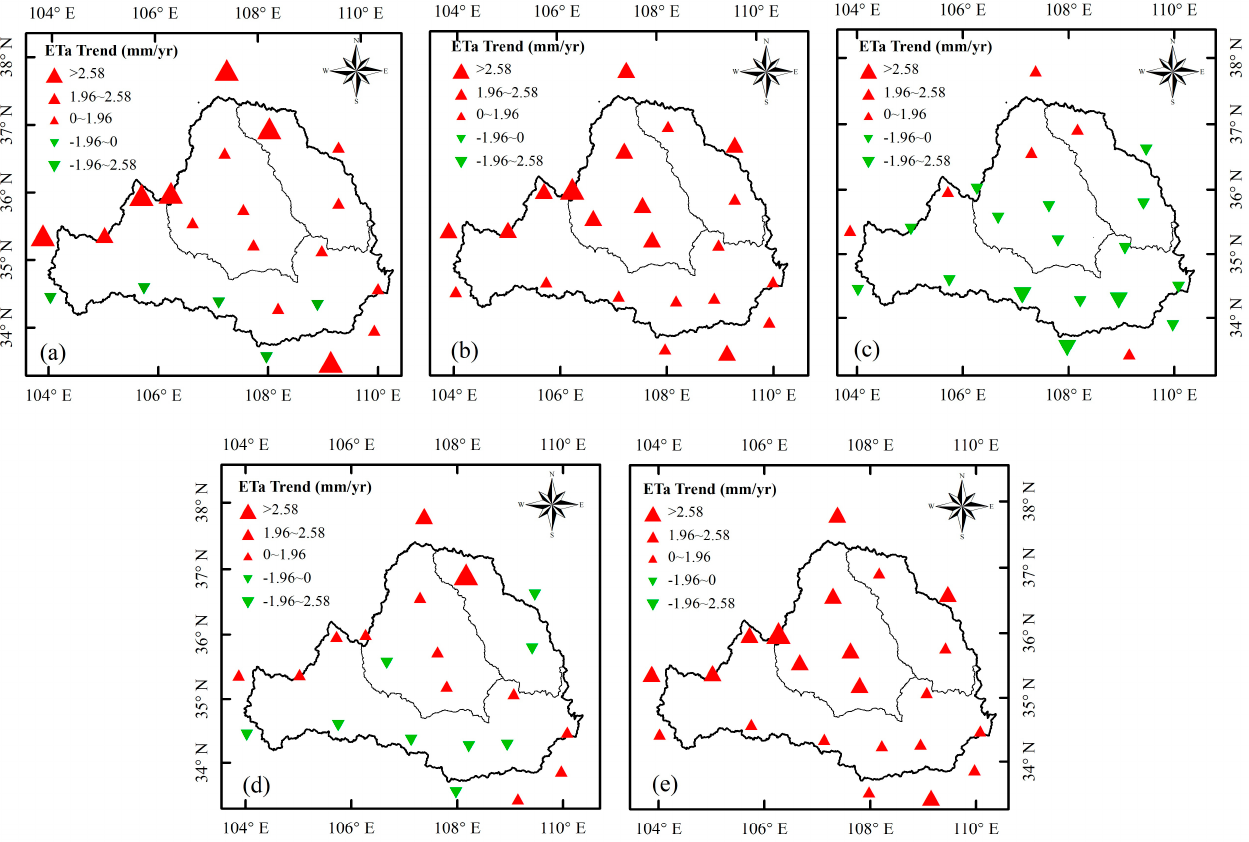
Figure 4. The values of Mann–Kendall test results of the ET a during 1970–2018 (( a ): Annual, ( b ): Spring, ( c ): Summer, ( d ): Autumn, ( e ): Winter).